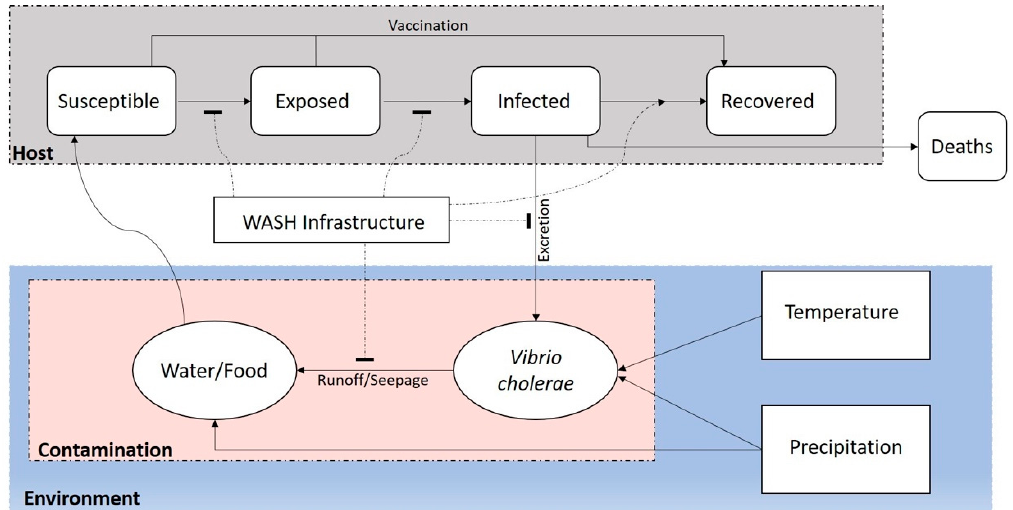
Figure 1. Fundamental cholera susceptible-exposed-infected-recovered (SEIR) transmission model. Susceptible (S) individuals of a population who have been exposed to Vibrio cholerae have the potential to acquire the disease from infected (I) individuals. At that point, they also have the potential to become infected (i.e., enter the infectious state), until eventual recovery from the disease (R) or death. Grey shading depicts the SEIR model, which also highlights the potential use of vaccines in curtailing the disease. Water, sanitation, and hygiene (WASH) infrastructure is a critical factor influencing cholera transmission at every stage of the model, from infected to susceptible individuals. Blue represents environmental factors, namely temperature and precipitation, that promote the growth and distribution of Vibrio cholerae , the causative agent of cholera, in aquatic reservoirs. Pink shows the potential transmission route from the environment to humans via contaminated food or water containing the V. cholerae . Arrow: positive effect; block: negative effect.